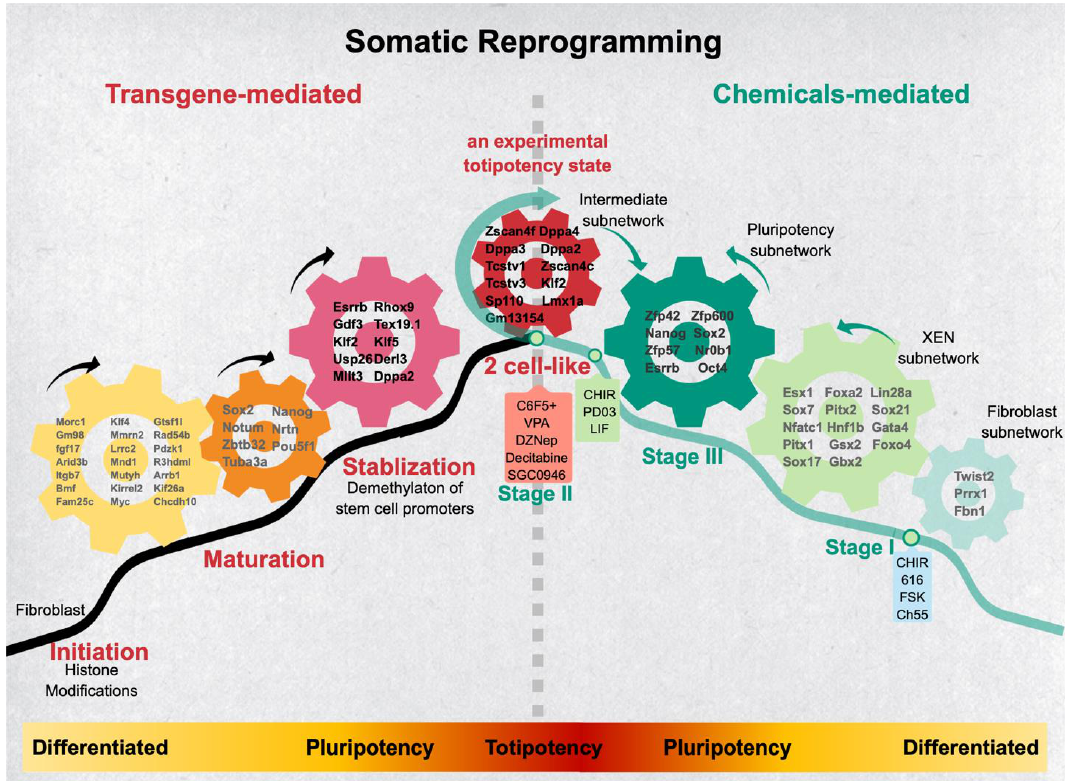
Figure 4. Distinct regulatory networks control epigenetic transits in tgiPSC and CiPSC. Genes and their correlated networks engage cell fate transit during reprogramming from MEF to iPSC. The left panel represents the roadmap of transgene-mediated iPSC (tgiPSC) formation, including the initiation, maturation, and stabilization phases. In this case, the first encountered obstacle is unlocking the fibroblast fate for MET. By contrast, chemical-based reprogramming adopts a different route (CiPSC; right panel). Instead of proceeding to MET, it first adopts the XEN-like cell fate by expressing the XEN-subnetwork genes. Subsequently, the network relays to the 2C-like program before acquiring the pluripotency circuitry. Although several recent reports have observed transient 2C-like programs during the process of tgiPSC, more evidence is needed in order to support whether such a 2C-like transit state is mandatory for tgiPSC formation [113 – 115]. Nevertheless, the common theme for both approaches shows that stepwise cell fate transitions are achieved through re- laying to different regulatory networks during its progression. Essential markers and specific hallmarks of each phase of reprogramming are indicated. 5.3. The Initiation Phase Based on the extensive transcriptome profiling of those reprogramming fibroblasts in the bulk culture, the loss of fibroblast identity (e.g., a highly expressed surface antigen Thy1 in fibroblasts) accompanied with cell morphology alternation was observed at this stage by engaging the mesenchymal-to-epithelial transition (MET). Such a signature is characterized by losing the expression of Snail1/2 and Zeb1/2 and gaining the epithelial makers [3]. The induction of miRNA-200 family members, Epcam, and Cdh1 indicates a cell fate change through waning the TGFbeta pathway [110,116,117]. One of the critical events underscores the needs of the Tet1, 2, and 3 activities during the initiation phase of chromatin remodeling as activation of the miR-200 family requires Tets [118]. After over- coming the barrier of MET, reprogramming cells acquire proliferation capability and re- futed apoptosis, allowing for replication-mediated epigenetic modification [56,58,59]. During the MET process, the loss of Thy1 and CD44, accompanying the gain of alkaline phosphatase and SSEA1, are typical changes observed in MEF-based reprogramming